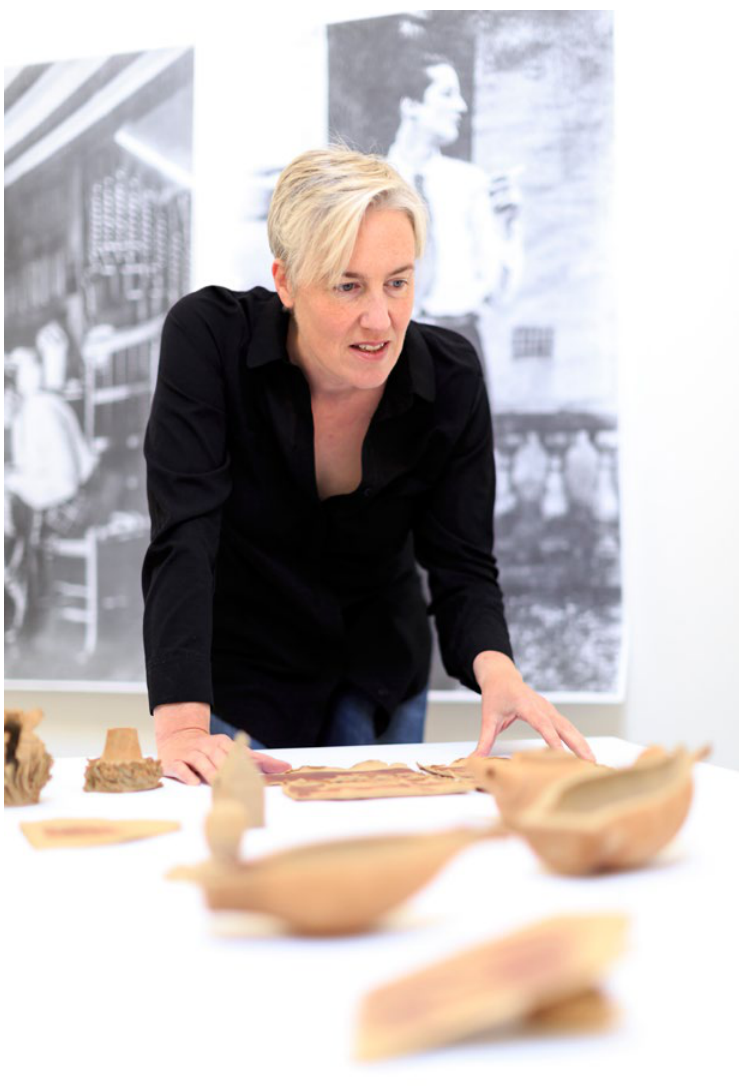
Figure 8.1 Amanda Chambers working in her